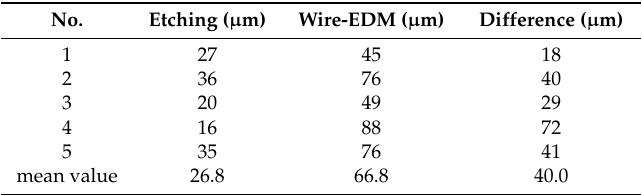
Table 10. Results of error in straightness.